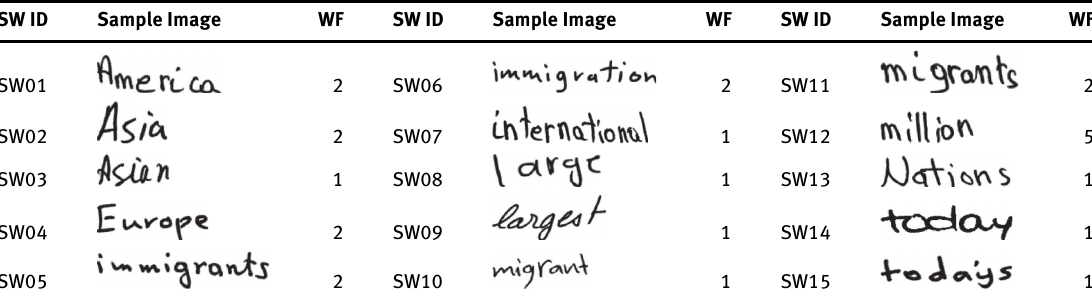
Table 1: Instances of Search